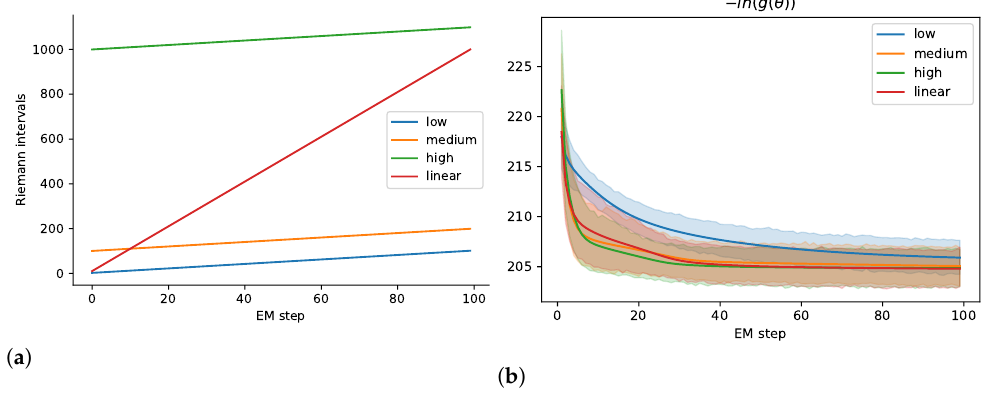
Figure 2. ( a ) Visual representation of the number of Riemann intervals over the EM steps for each profile ϕ i . The total number of Riemann intervals computed over 100 EM iterations are: 5150 for “low”, 14,950 for “medium”, 50,500 for “linear” and 104,950 for “high”. ( b ) For each profile, average evolution of the negative log-likelihood, with standard deviation, over 50 simulations. The results are fairly similar, in particular between “medium”, “high” and